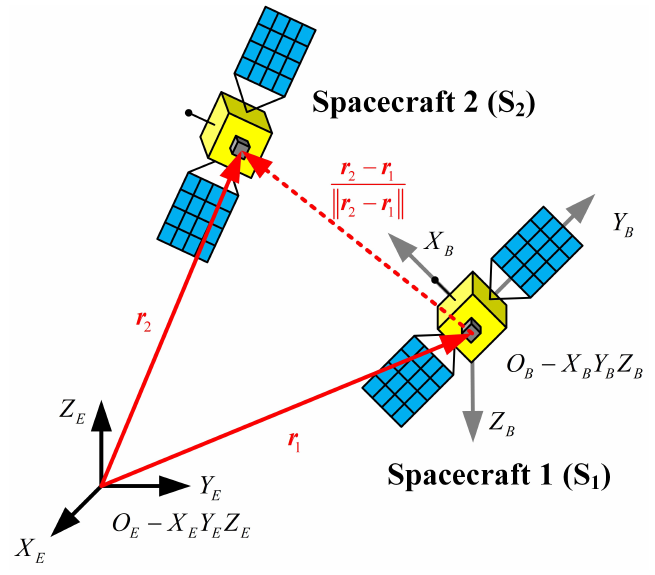
Figure 1. Diagram of a two-spacecraft